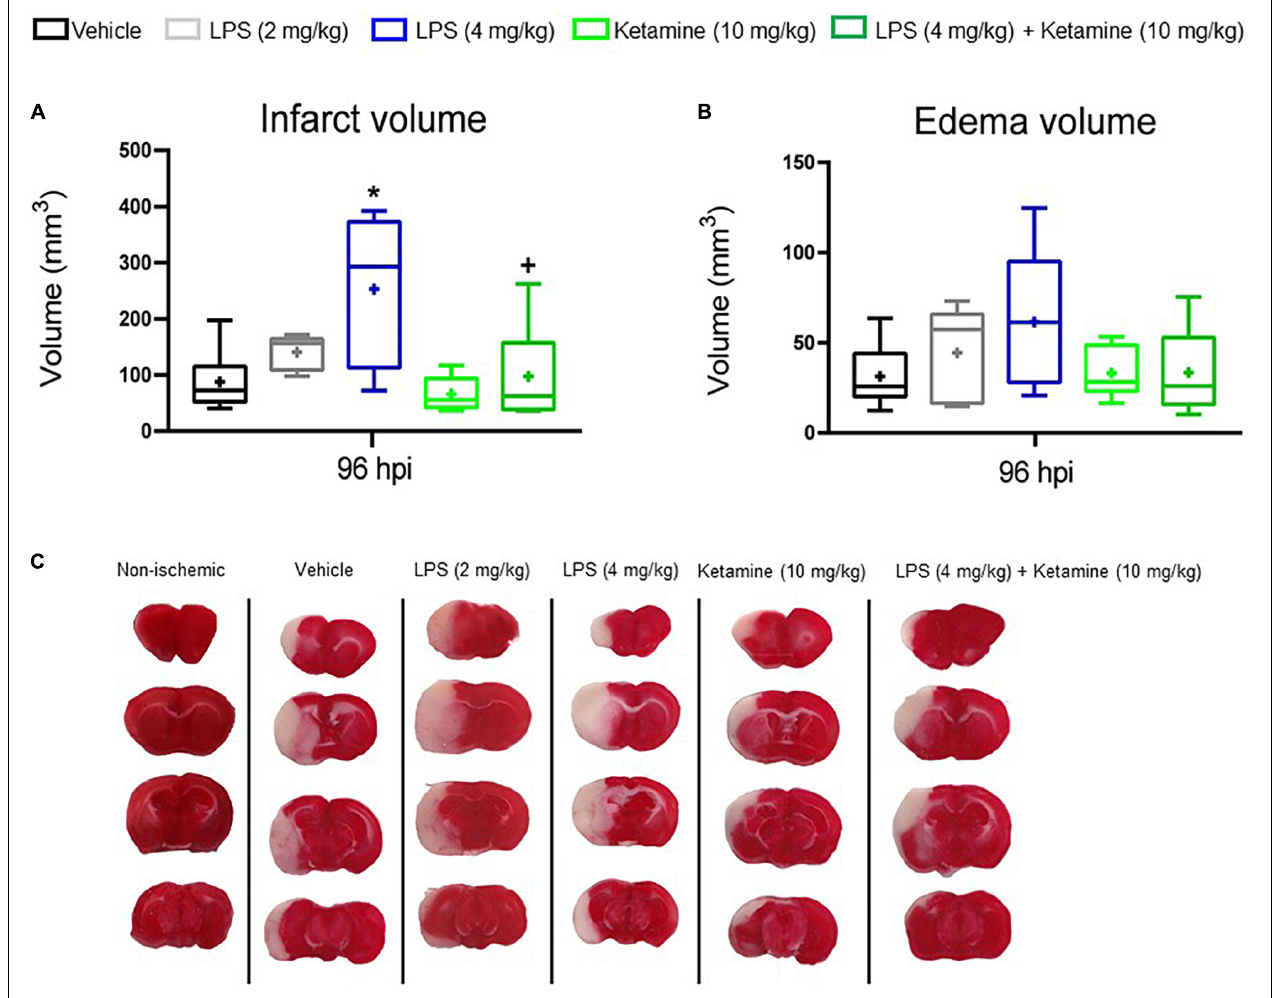
FIGURE 3 | Effects of LPS-induced sepsis and ketamine on infarct volume and brain edema. (A) Infarct volume and (B) brain edema volume assessed by TTC staining in the brains of mice exposed to transient MCAO followed by vehicle or LPS (2 or 4 mg/kg) delivery at 24 hpi. 30 min later, vehicle or ketamine (10 mg/kg) was injected in mice receiving vehicle or LPS (4 mg/kg). (C) Representative TTC-stained coronal brain sections are also shown at 96 hpi (that is, at 72 h after LPS.induced sepsis). Note that LPS-induced sepsis (4 mg/kg) significantly increased infarct volume, which was reversed by ketamine. Ketamine alone had no effect. Data are medians (lines inside boxes)/means (crosses inside boxes) ± interquartile ranges (IQR; boxes) with minimum/maximum values as whiskers ( n = 6 animals/group). * P < 0.05 compared with the ischemic vehicle; + P < 0.05 compared with ischemic LPS (4